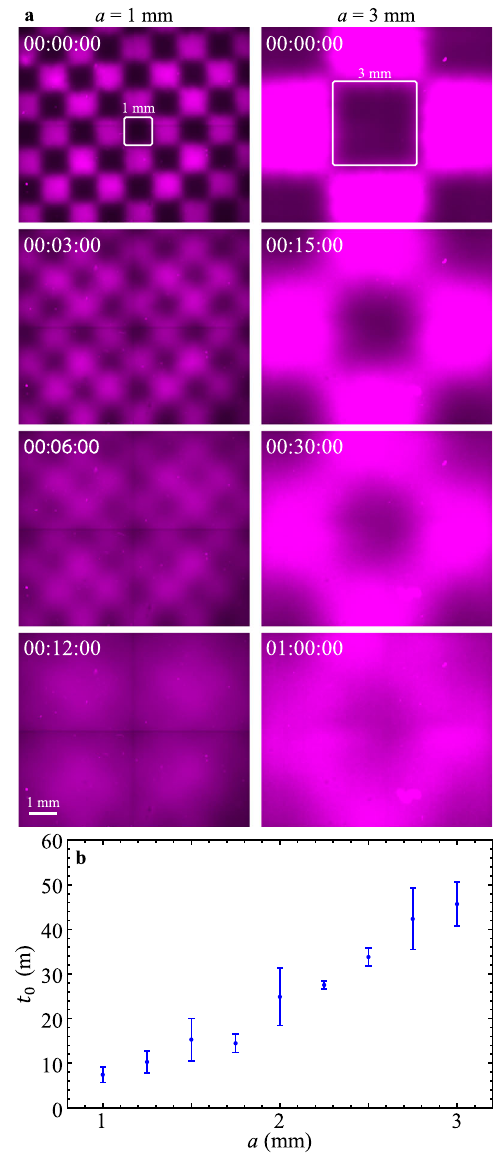
Fig. 7 | (Experimental results) Fluid activated in a checkerboard pattern mixes faster when the checkerboard grid is smaller. a Checkerboard-patterned UV lights are used to activate active fl uid and caged fl uorescent dyes. (Supplementary Movie5). b Themixingtimeofthecheckerboard-activated fl uidincreaseswithgrid size, which demonstrates that the mixing ef fi cacy of active fl uid depends on dis- tribution of activity: more nonuniform active fl uid mixes the system more slowly. Each error bar in t 0 represents the standard deviation of two